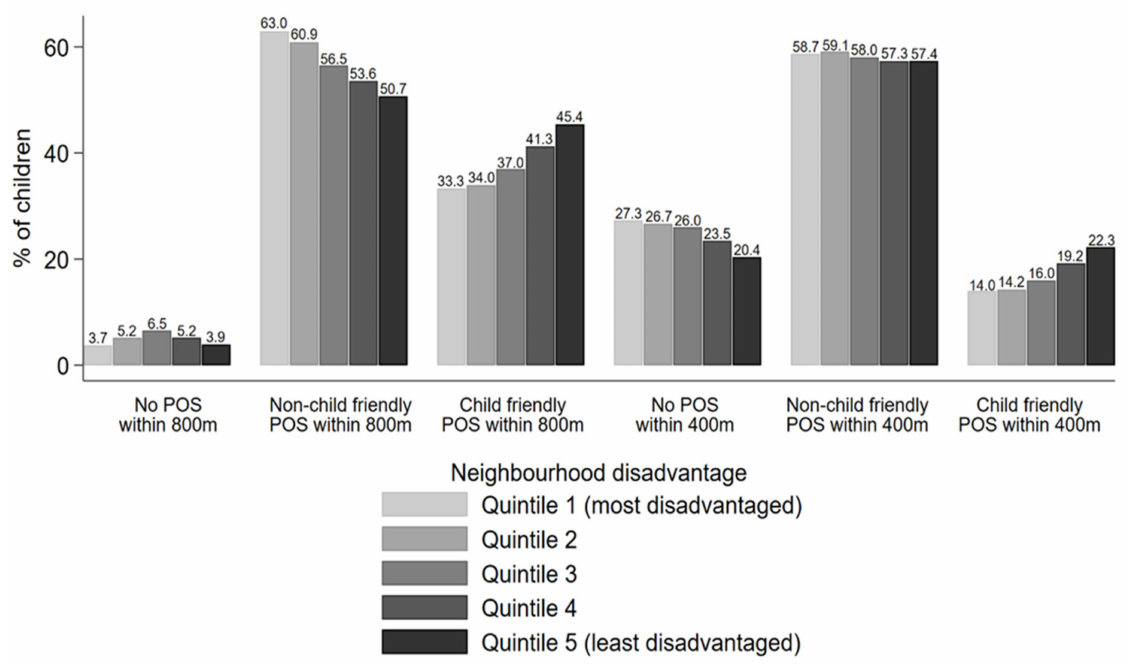
Figure 2. Percentages of children within each maternal education subgroup who have access to public open space (none, non-child friendly, child friendly) within 800 m and 400 m from home along the road network). Children with missing data on neighbourhood disadvantage (n = 829) not shown. POS: public open space. Child friendly POS defined as having both playground and public toilet nearby; non-child friendly POS defined as those lacking either/both of these child friendly features. Table 2. Associations between public open space access (non-child friendly and child friendly) and children’s odds of mental health outcomes (externalising, internalising, competence) across Australia’s eight capital